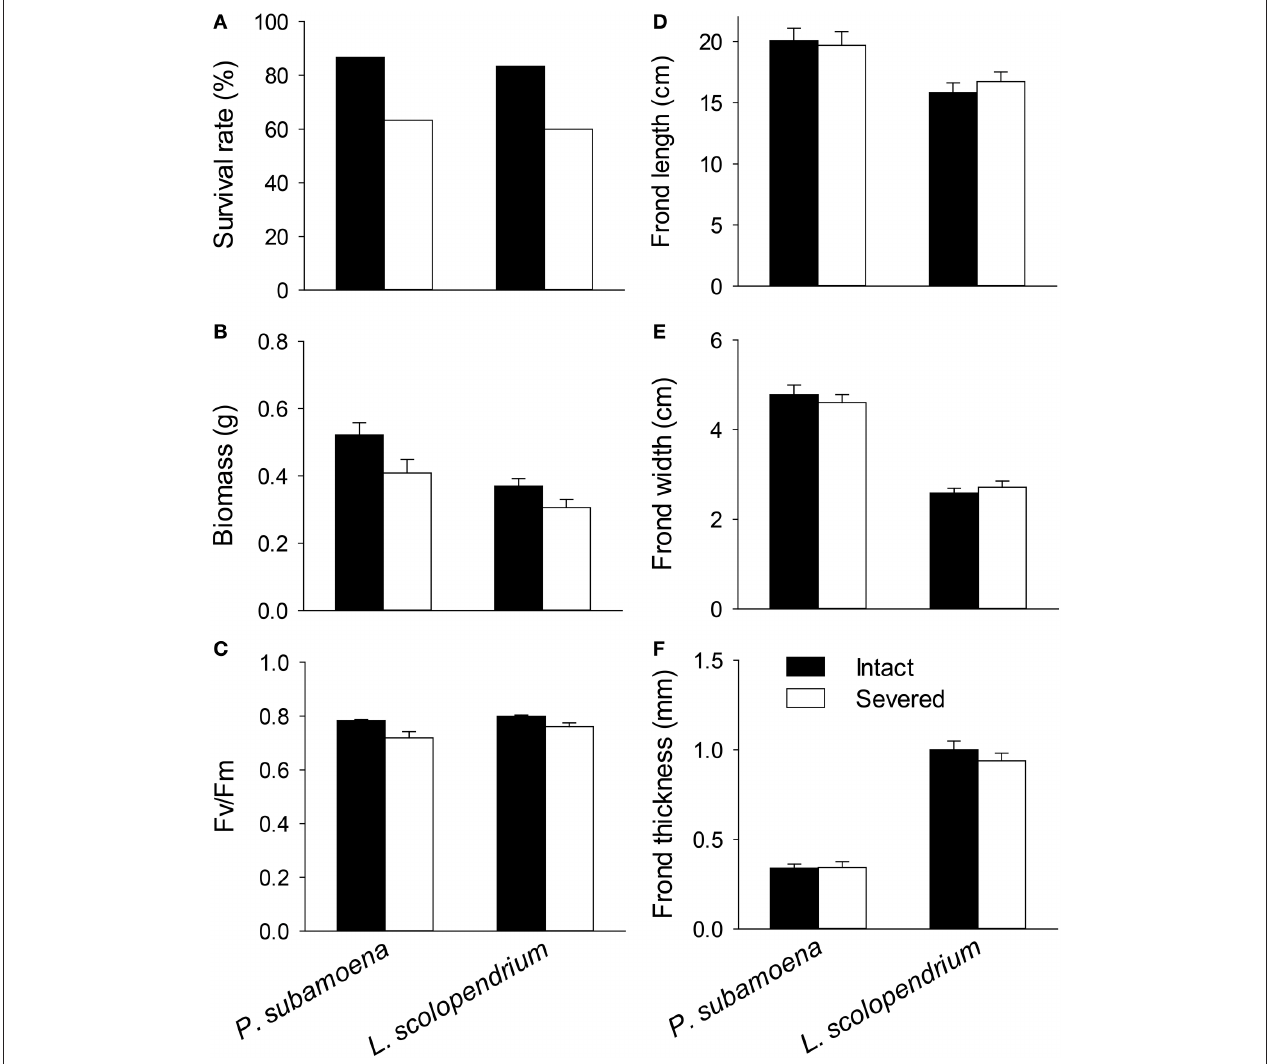
FIGURE 1 | Effects of rhizome severing on (A) survival, (B) biomass, (C) F v /F m , and (D–F) frond morphology of the two epiphytic ferns in the individual experiment. Error bars represent SEs.